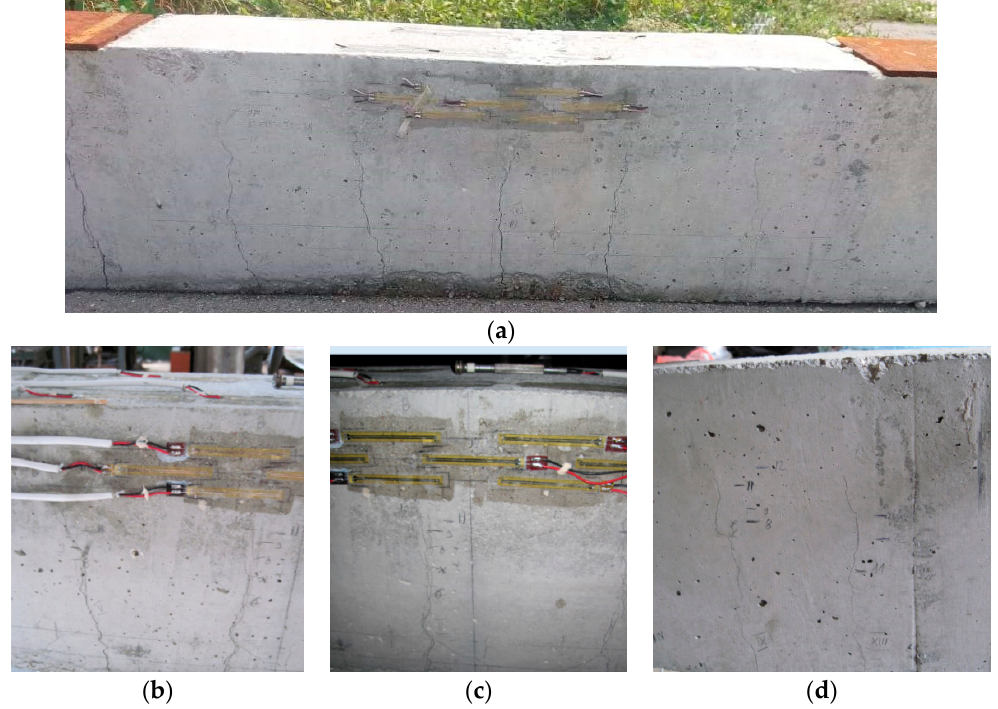
Figure 7. Different normal cracks in the tested beams, ( a ) typical general view, ( b ), ( c ), ( d ) detailed views (personal archive).